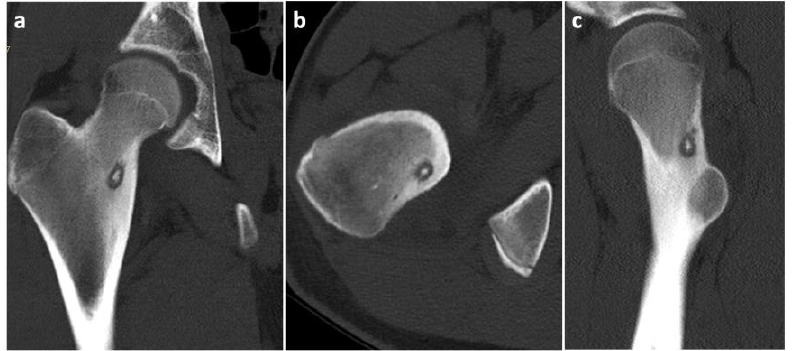
Figure 2. CT scans of the osteoid osteoma in different projections. ( a ) Frontal view; ( b ) Transverse view; ( c ) Sagittal view.